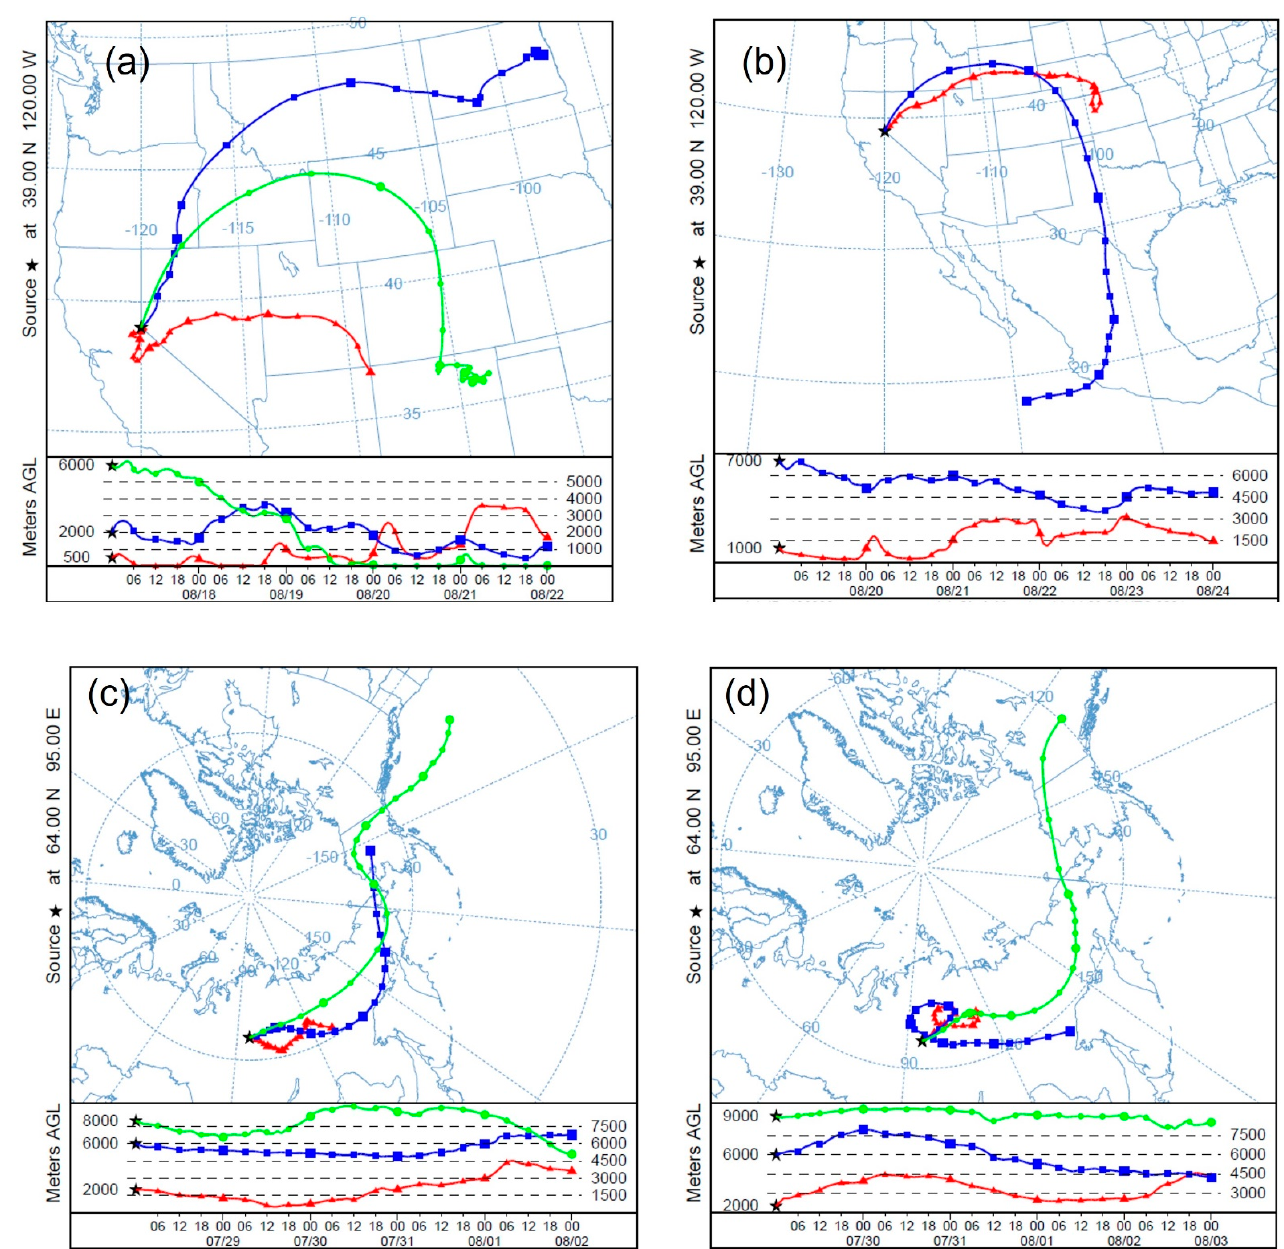
Figure 7. ( a ) Air mass forward trajectories starting on 17 August 2020 in California at 500 m, 2000 m and 6000 m above ground level. ( b ) Forward trajectories starting on 19 August 2020 at 1000 m and 7000 m above ground level. ( c ) Air mass forward trajectories starting on 28 July 2019 in Krasnoyarsk Krai at 2000 m, 6000 m and 8000 m above ground level. ( d ) Forward trajectories starting on 29 July 2019 at 2000 m, 6000 m and 9000 m above ground level.